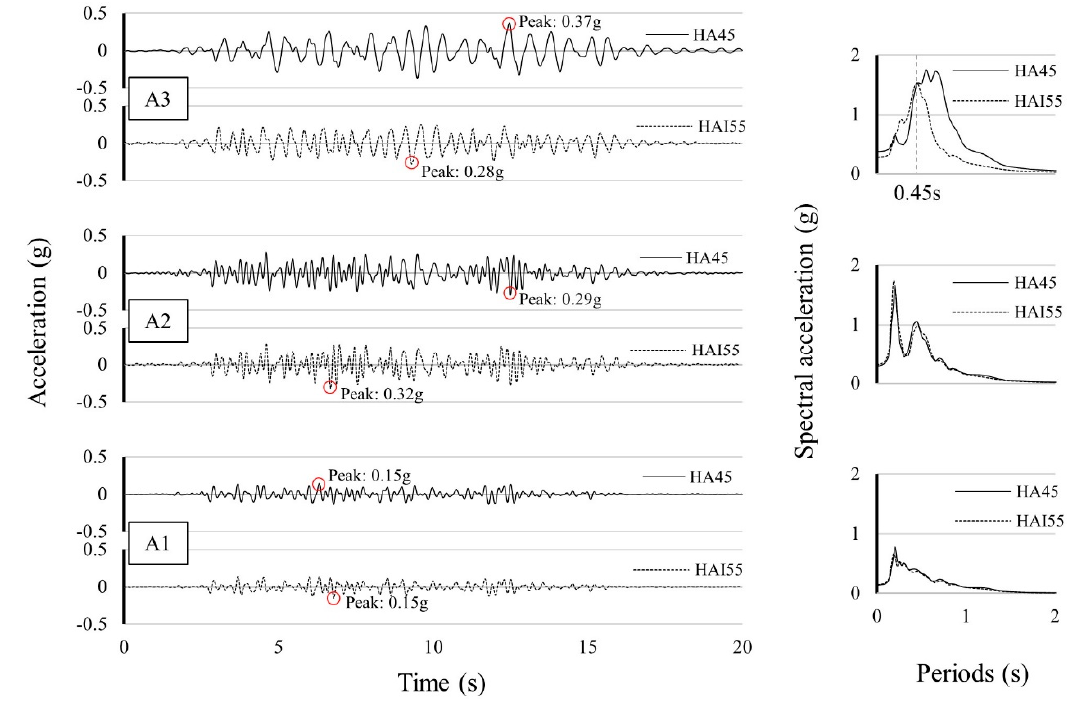
Figure 6. Acceleration time histories of horizontal ground model (0.15 g) (scaled to the prototype).